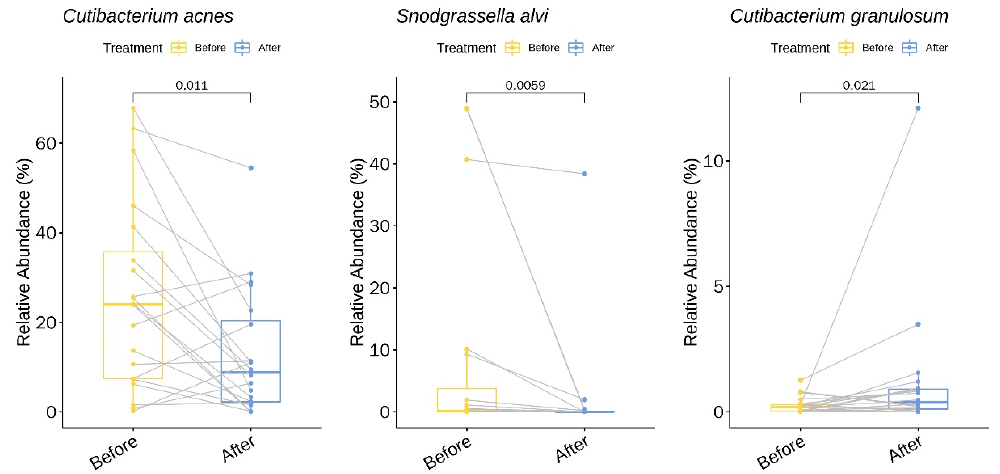
Figure 3. Bacterial species with a significant change in the relative abundance (%) upon doxycycline treatment.